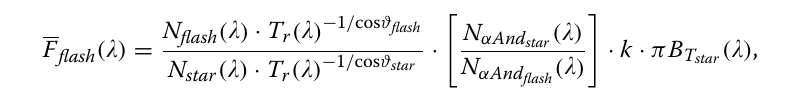
Spectral types and magnitudes are obtained from the SIMBAD (2021) database a Effective temperatures are obtained from B–V color indexes according to Table 3 in Flower (1996) b The type and magnitudes could be slightly modified by the recent update